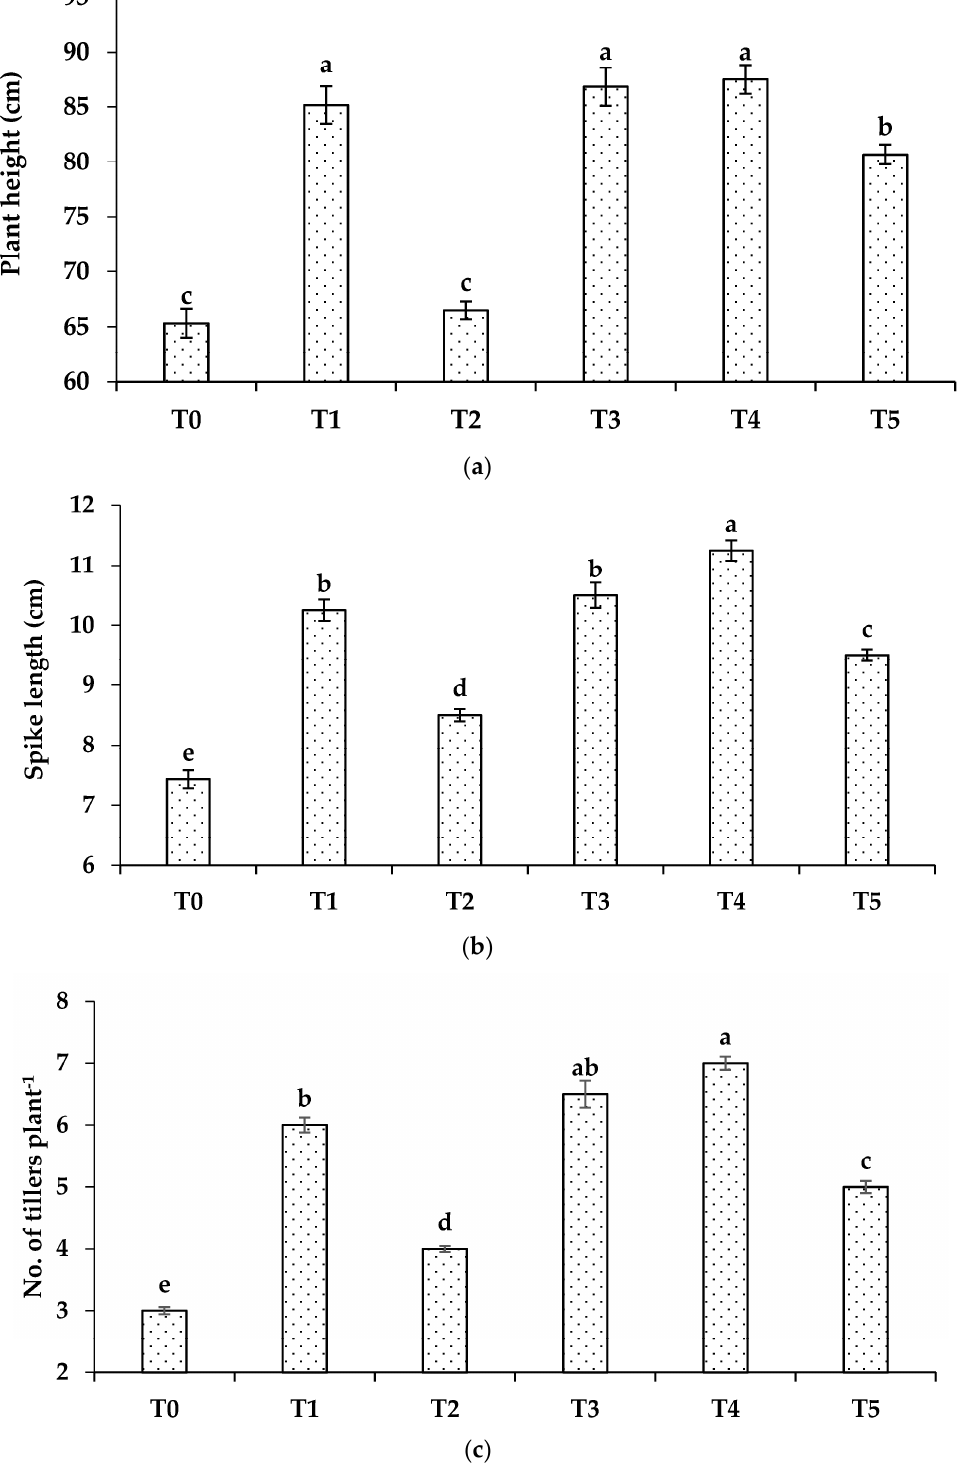
Figure 2. Growth parameters of wheat: ( a ) plant height; ( b ) spike length; ( c ) No. of tillers per plant, grown with different formulations of urea. Where T 0 = No Zn; T 1 = recommended Zn (ZnSO 4 ); T 2 = ZSB; T 3 = 1.5% Zn coated urea (ZnO); T 4 = 1.5% bio-activated Zn coated urea (ZnO); and T 5 = 1.5% Zn blended urea (ZnO). Bars showing the same letters do not differ significantly (p < 0.05) .